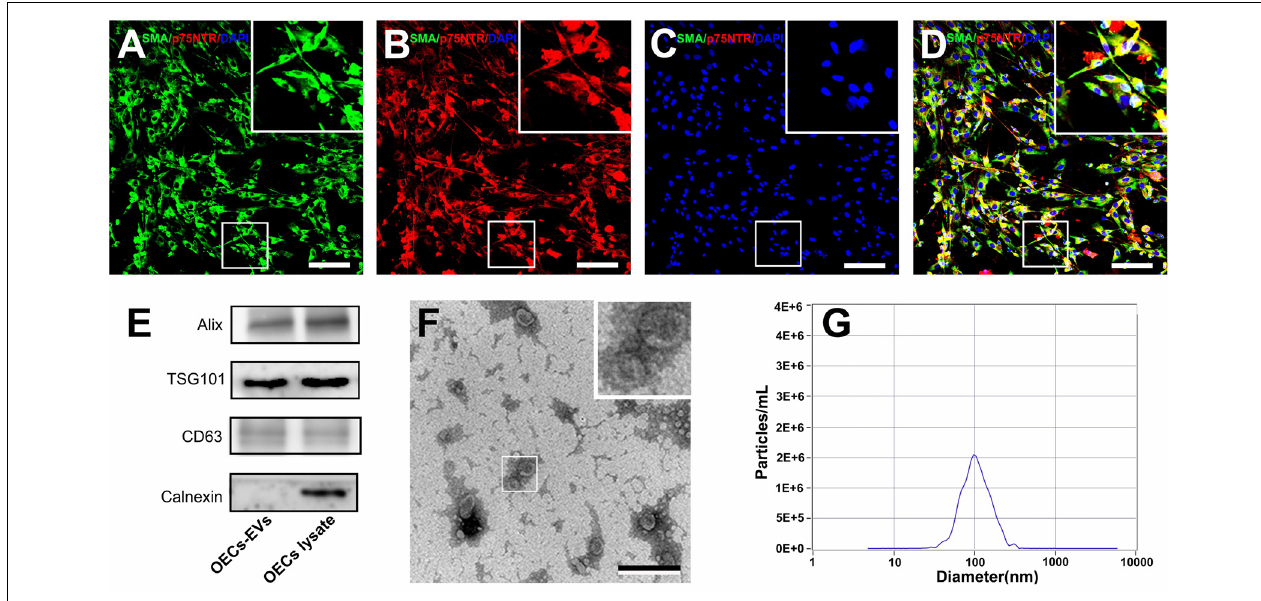
FIGURE 1 | Characterization of olfactory ensheathing cells and isolated EVs. Notes: double immunofluorescent staining of cultured OECs showed the expression of SMA (green; A ) and p75 NTR (red; B ) with DAPI nuclear counterstaining (blue; C ). Merge images revealed an OECs purity of more than 96% (D) . Western blot analysis of EVs isolated from the supernatant of cultured OECs confirmed the presence of EVs marker proteins of Alix, TSG101, CD63, and the absence of non-exosomal protein (calnexin; E ). The TEM analysis of isolated EVs (F) . Representative traces from nanoparticle tracking analysis (NTA; G ). The upper right corner of the images (A–D,F) is a higher magnification of the boxed area in (A–D,F) . Scale bars: (A–D) 100 µ m; (F) 200 nm. Abbreviations: OECs, olfactory ensheathing cells; SMA, smooth muscle α -actin; DAPI, 4 (cid:48) ,6-diamidino-2-phenylindole; EVs, extracellular vesicles; TEM, transmission electron microscopy; NTA, nanoparticle tracking